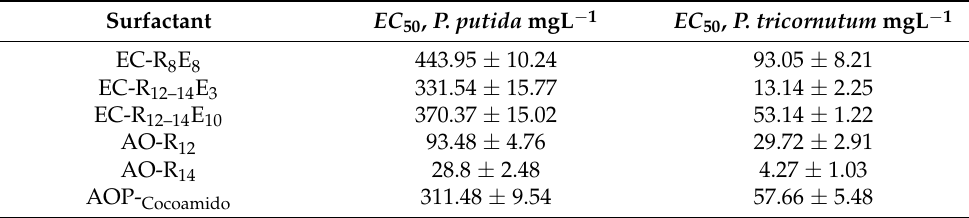
Table 4. Toxicity values (95% CI) of individual surfactants to bacteria P. putida (exposure time: 16 h and microalgae P. tricornutum (exposure time: 72 h).